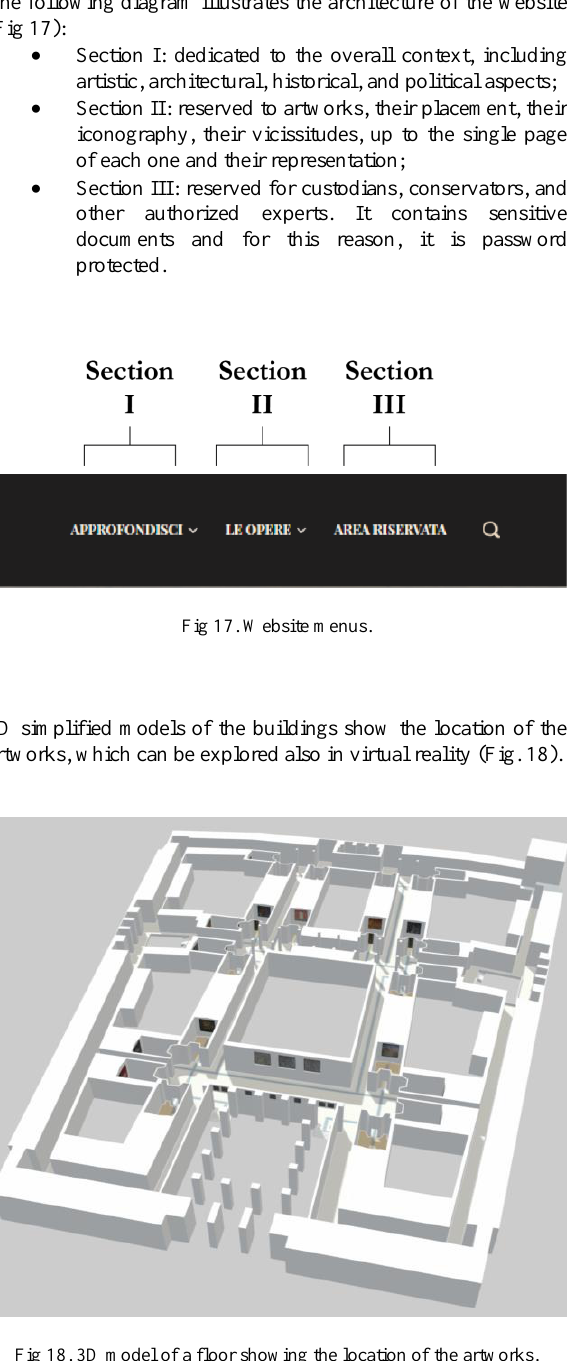
Fig 18. 3D model of a floor showing the location of the artworks.